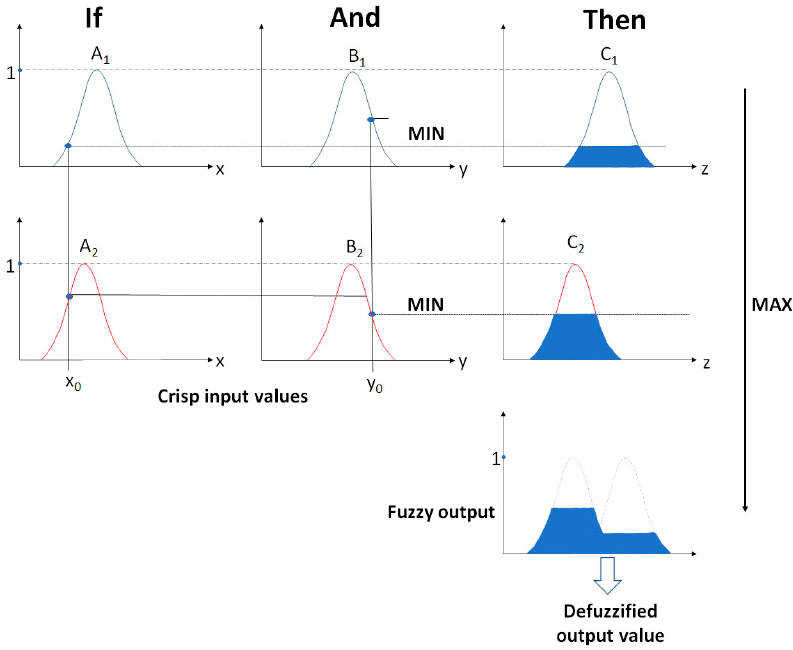
Figure 4. Functioning of FIS of MAMDANI model on the example of Gaussian curves using MIN and MAX operator.